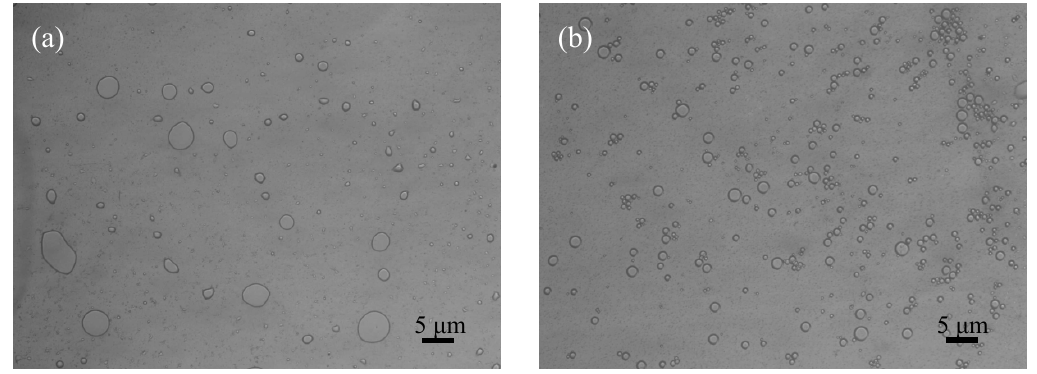
Figure 4. Optical microscopy images of the kerosene emulsions prepared by ultrasonic processor ( a ) without the addition of octyl hydroxamate ( b ) with the addition of 0.05 wt % octyl hydroxamate.